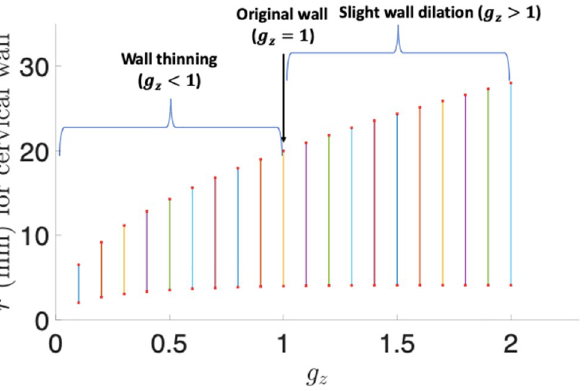
Fig 6. The cervical wall radius and thickness for the axial growth parameter g The top pints of the vertical lines represent r 4 , the bottom points represent r 1 , and the length of each vertical line represents the wall